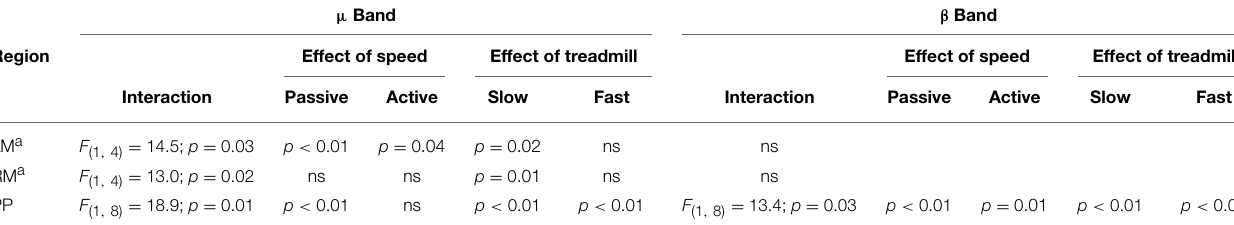
TABLE 2 | Significant interaction effects between speed and treadmill type on spectral